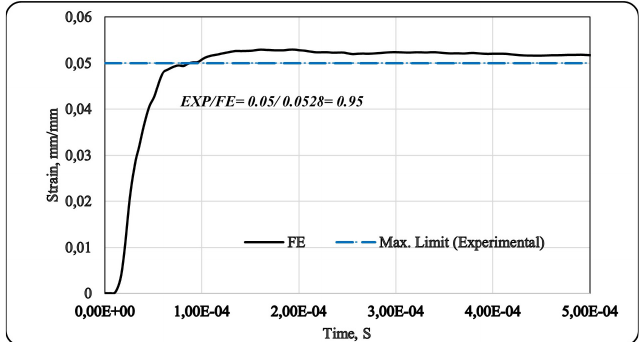
Figure 11 -Comparison between experimental & FE results of steel strain detected by strain gauge at the center (Point 1) of UHPC-4